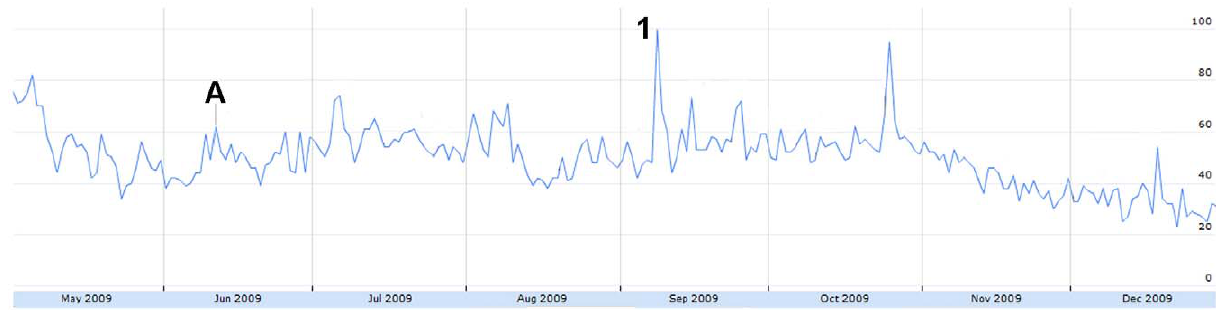
Figure 13. The relative proportion of tweets sharing personal opinions & interest from May 1 to December 31, 2009. Figure was scaled to the highest peak on Sept. 8 where 5.34% of all tweets shared personal opinions. The peak was assigned a score of 100. A=June 11: WHO